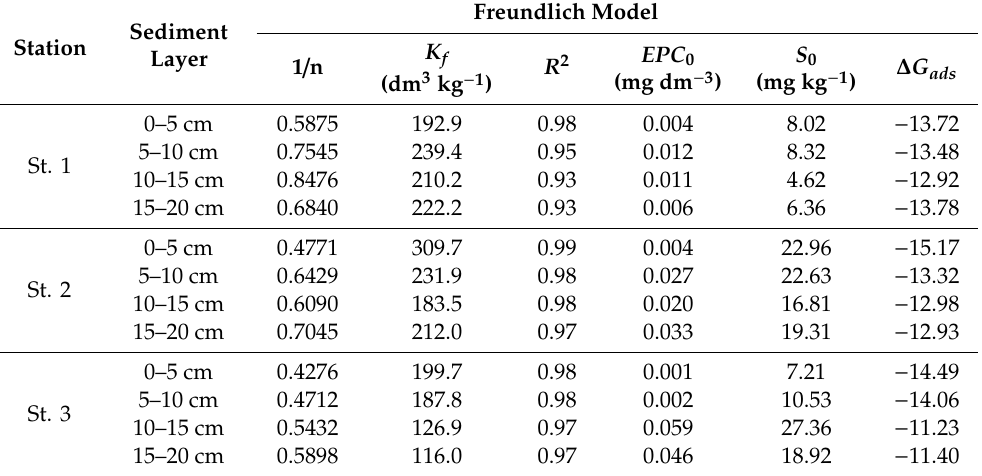
Table 2. The assessed values of the Freundlich sorption model characteristics, “native sorbed phosphorus” values and Gibbs free energy for profundal bottom sediment of Długie Lake.